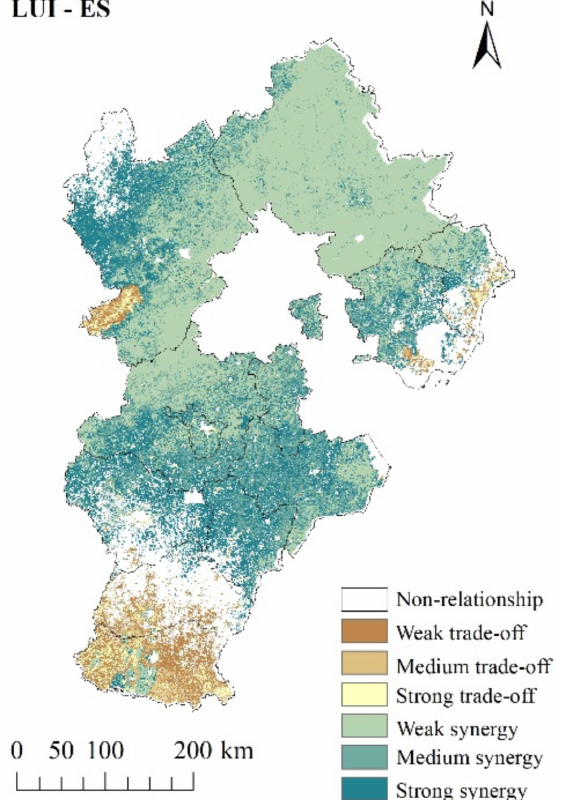
Figure 7. The distribution of trade-offs/synergies between LUI and ESs in Hebei during 2000–2015. Table 6. The proportion of trade-off/synergy area between LUI and ESs in Hebei during 2000–2015. LUI-ES